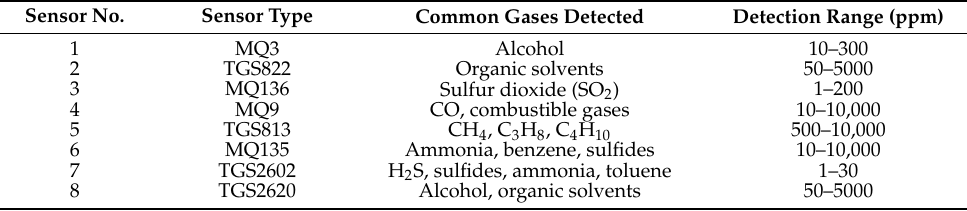
Figure 1. Research materials utilized. Photos (clockwise) include: ( a ) greenhouse research plots; ( b ) urea fertilizer powder; ( c ) cucumber fruit harvested for the VOC emission analysis and classifica- tions based on the amount of urea fertilizer applied; and ( d ) the experimental 8-sensor MOS e-nose system (sensor array in a portable box, cucumber fruit VOC sampling chamber, and computer interface). Table 1. Sensor type, sensitivity, and detection ranges for the MOS experimental electronic nose. Sensor